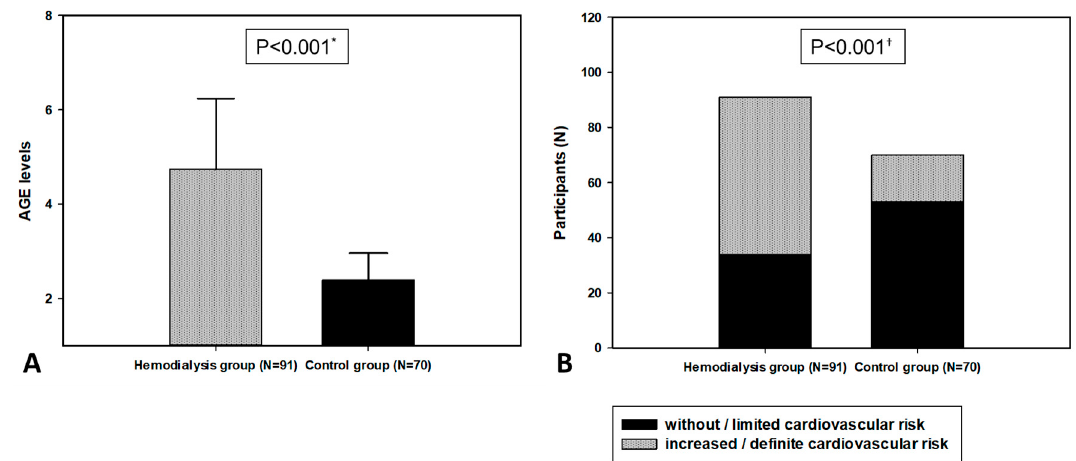
Figure 1. Advanced glycation end product (AGE) levels in hemodialysis and control groups ( A ) and categories of cardio- vascular risk according to AGE levels in study population ( B ). Abbreviations: AGEs, advanced glycation end products. *, t -test for independent samples. †, chi-square test.